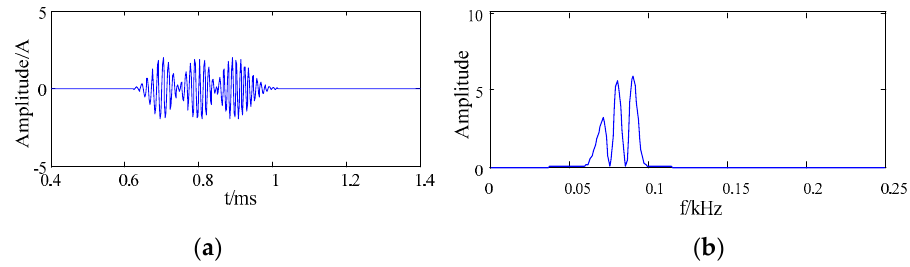
Figure 3. The waveform and the frequency spectrum of the simulation signal ( a ) the waveform; ( b ) the frequency spectrum.